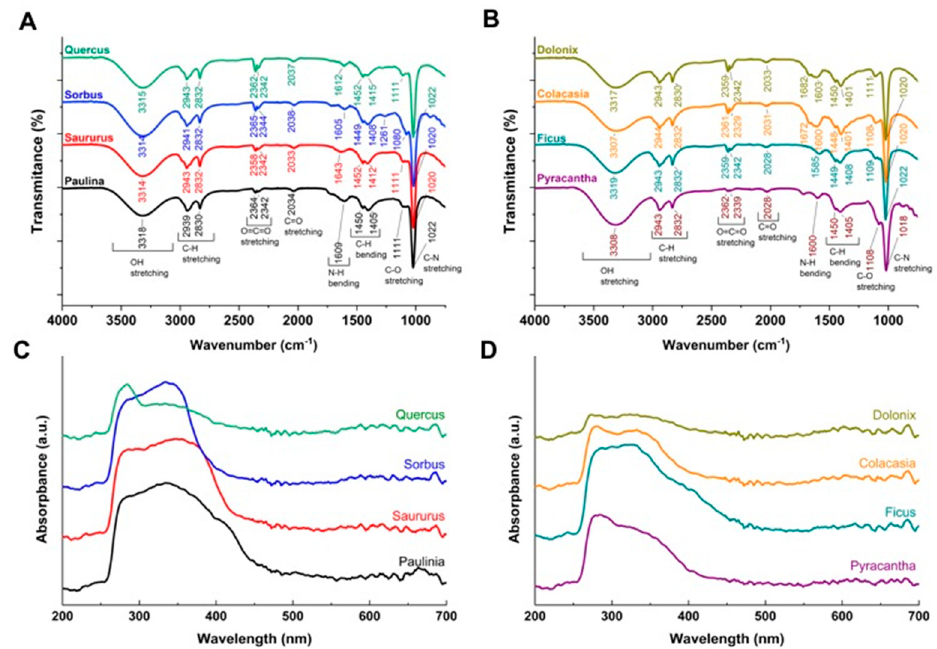
Figure 2. Analysis of phytochemical constituents in all eight plant extracts, including Pyracantha angustifolia and Paullinia cupana . Fourier-transform infrared (FTIR) spectra of ( A ) Quercus, Sorbus, Saururus, and Paulina ; and ( B ) Dolonix, Colacasia, Ficus , and Pyracantha . UV-Vis absorption spectra of ( C ) Quercus, Sorbus, Saururus, and Paulina ; and ( D ) Dolonix, Colacasia, Ficus , and Pyracantha .